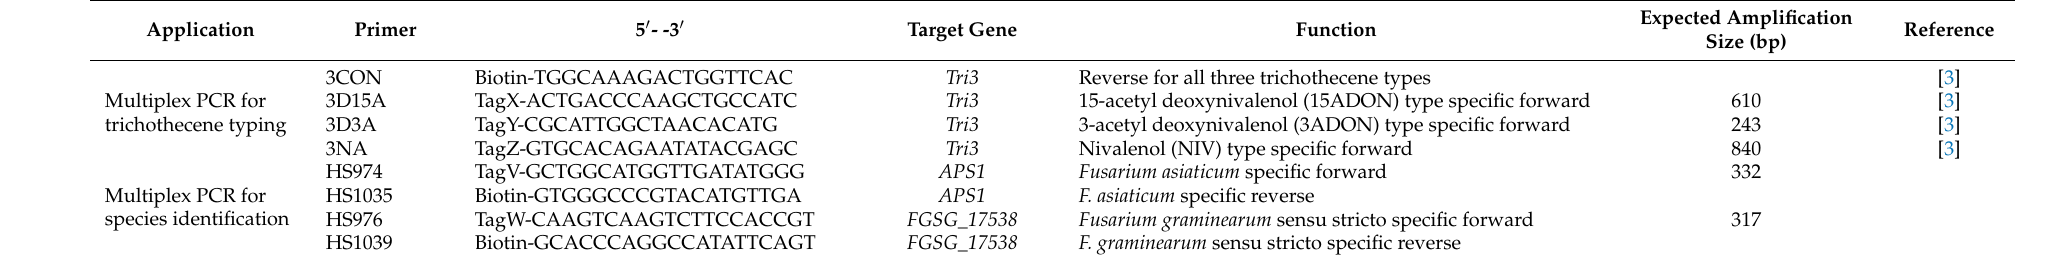
Table 2. Primers used in the current